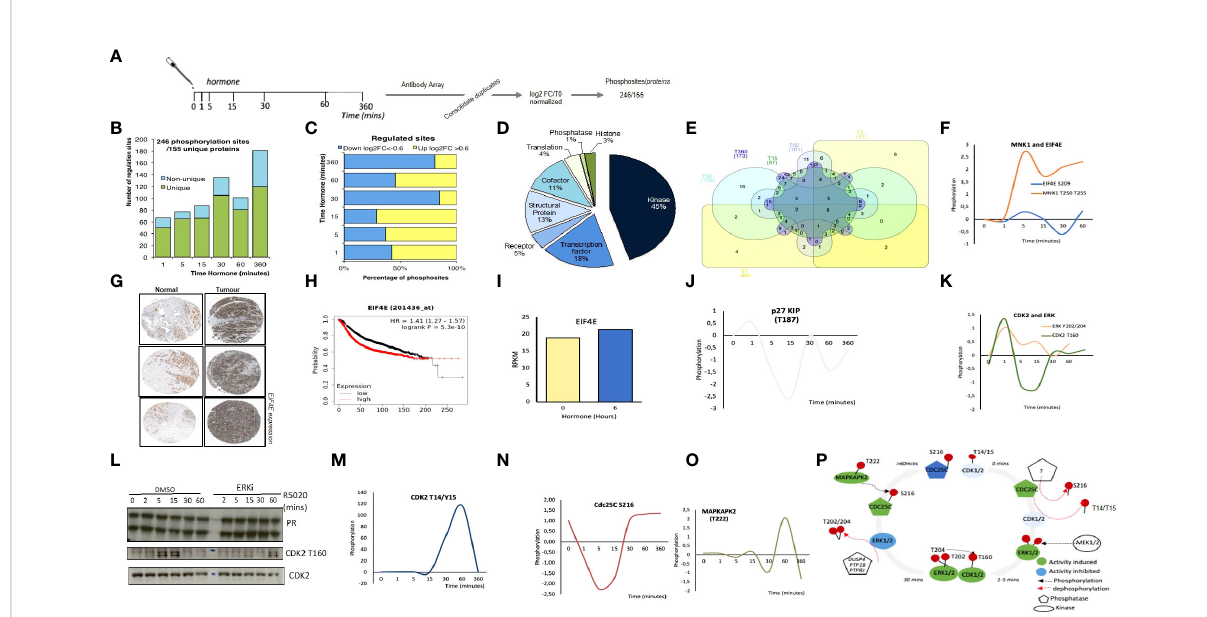
FIGURE 1 Targeted Antibody Array Phosphorylation data following hormone. (A) Schematic overview of experimental procedure. Synchronized T47D cells were exposed to hormone for the length of time indicated. Triplicate samples were harvested and phosphorylated proteins were identi fi ed